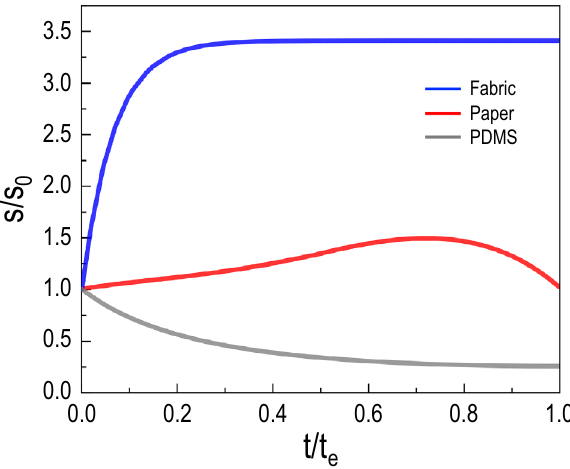
Figure 5. Surface area evolution subjected to evaporation. The temporal surface area S contributes to evaporation flux changes for the different substrates. The surface area values are normalized to the initial values S 0 , and the time t is normalized to the experimental final acquisition time t e